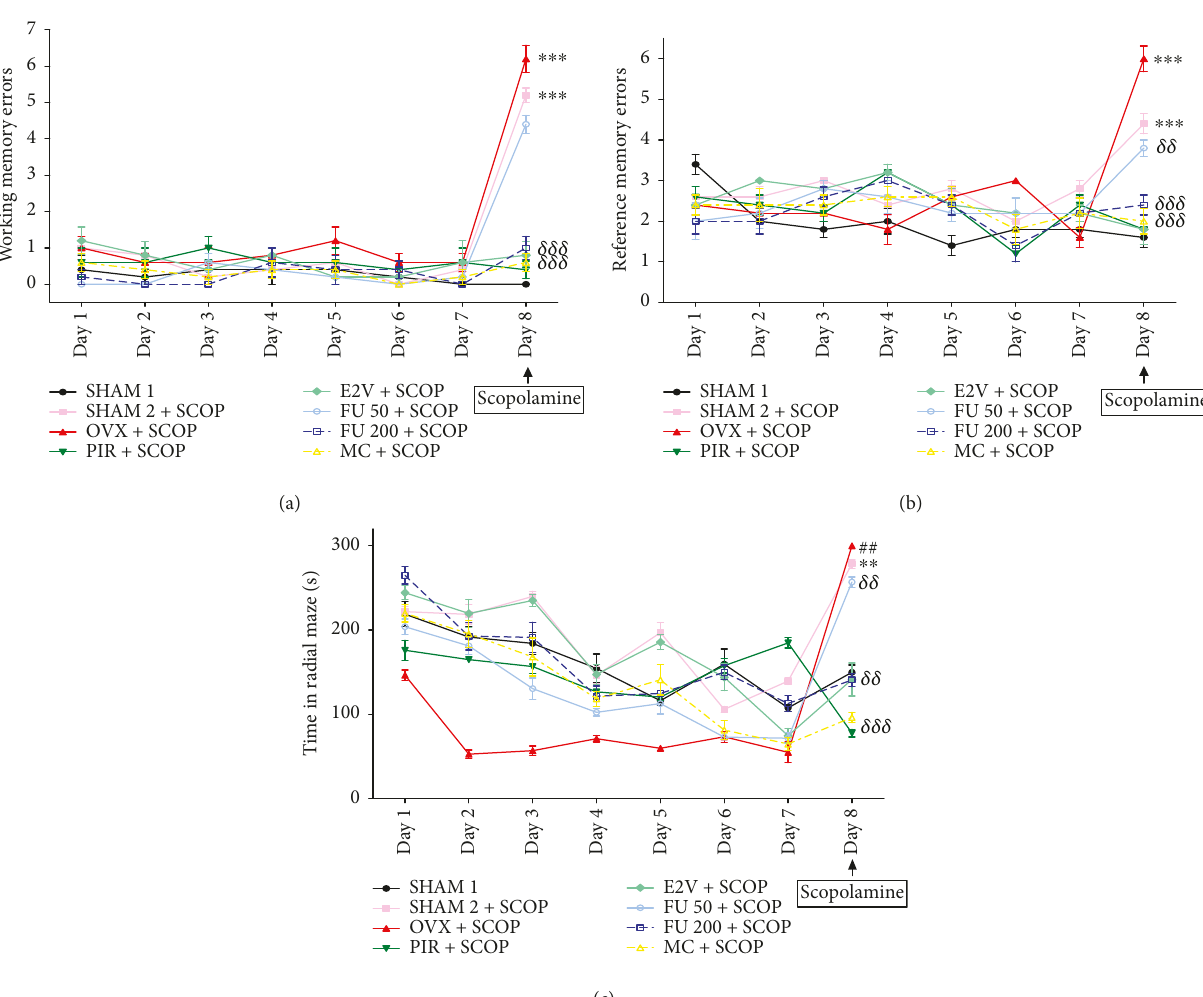
Figure 5: Graphic representation of the working memory (a) and spatial reference memory (b) errors as well as the time past in radial maze (c) before and after scopolamine exposition in rats treated with di ff erent substances into the Y-maze. SHAM 1=sham-operated rats treated with vehicle as normal control 1; SHAM 2=sham-operated rats treated with vehicle as normal control 2; OVX =ovariectomized rats treated with vehicle as negative control; PIR=ovariectomized rats treated with piracetam at the dose of 1.5mg/kg BW as positive control 1; E2V=ovariectomized rats treated with estradiol valerate at the dose of dose 1 mg/kg BW as positive control 2; FU 50 and 200=ovariectomized rats treated with F. umbellata aqueous extract at the doses of 50 and 200mg/kg BW, respectively; MC=ovariectomized rats treated with 7-methoxycoumarin at the dose of 1mg/kg BW. SCOP=animal that received a single dose of scopolamine (2 mg/kg BW). ∗∗ p < 0 01 and ∗∗∗ p < 0 001 as compared to the SHAM 1 group; ## p < 0 01 as compared to the SHAM 2 group; δδ p < 0 01 and δδδ p < 0 001 as compared to the OVX